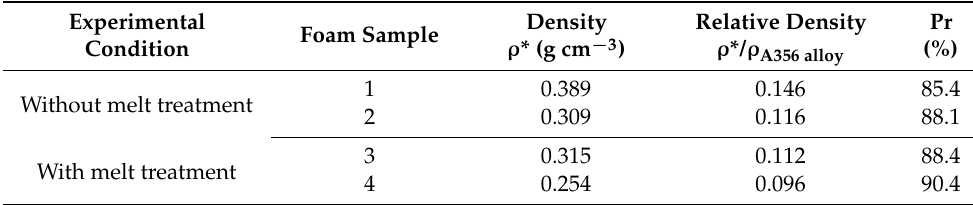
Table 3. Experimental densities and porosity of the A356 alloy foams. Experimental